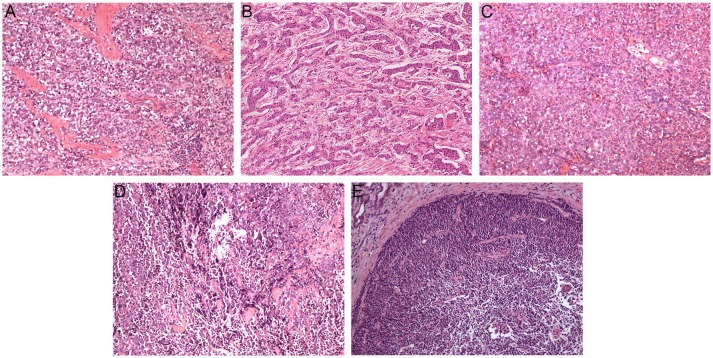
Pathological findings of biliary neuroendocrine neoplasms (hematoxylin-eosin, original magnification × 100). Tumor cells were poorly differentiated and arranged in cellular nests and sheets (A–C). Neuroendocrine carcinoma cells with differentiated adenocarcinoma cells (D,E). (A) Gallbladder neuroendocrine carcinoma; (B) Biliary tract neuroendocrine carcinoma; (C) Ampulla of Vater neuroendocrine carcinoma; (D) Gallbladder mixed adenoneuroendocrine carcinoma; (E) Ampulla of Vater mixed adenoneuroendocrine carcinoma.